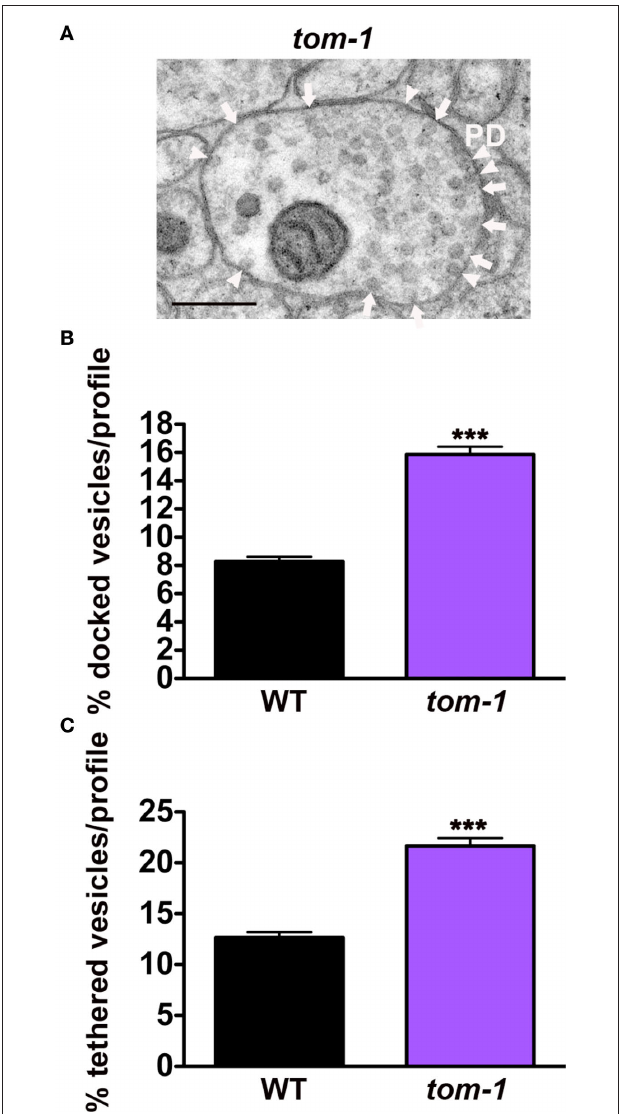
FigUre 6 | TOM-1 negatively regulates synaptic vesicle docking and tethering. (A) Representative electron micrograph of an NMJ profile from a tom-1(ok285) mutant. Arrowheads indicate plasma membrane docked synaptic vesicles, arrows indicate tethered synaptic vesicles ( < 25 nm of the plasma membrane), PD presynaptic density, scale bar 200 nm. Average docked (B) and tethered (C) synaptic vesicles expressed as a percentage of total vesicles per synaptic profile. tom-1(ok285) ( n = 115 synaptic profiles, vesicle density 22.1 ± 0.9), wild-type ( n = 178 synaptic profiles, vesicle density 20.2 ± 0.6). *** p < 0.0001 relative to